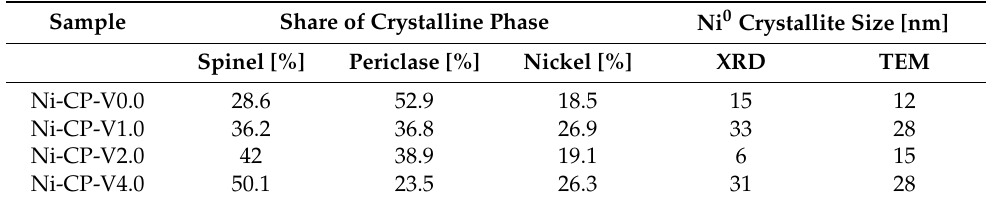
Table 3. Results of Rieteveld refinements and Ni 0 crystallite size calculated based on Scherrer’s equation, for reduced hydrotalcite-derived